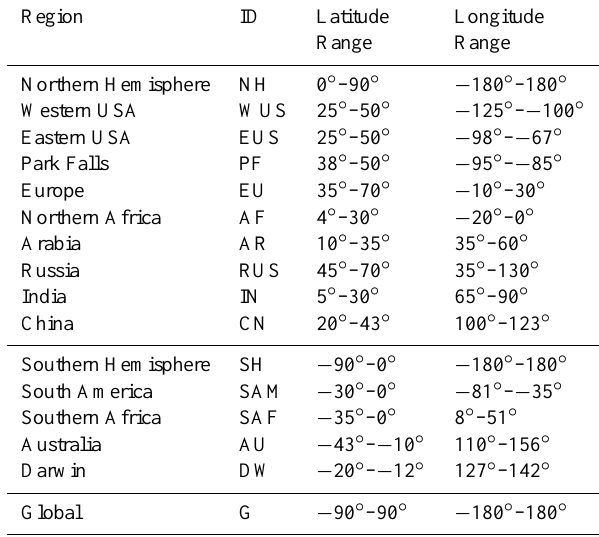
Table 2. Latitudes and longitudes of the regions used in this study (see also Fig. 8).